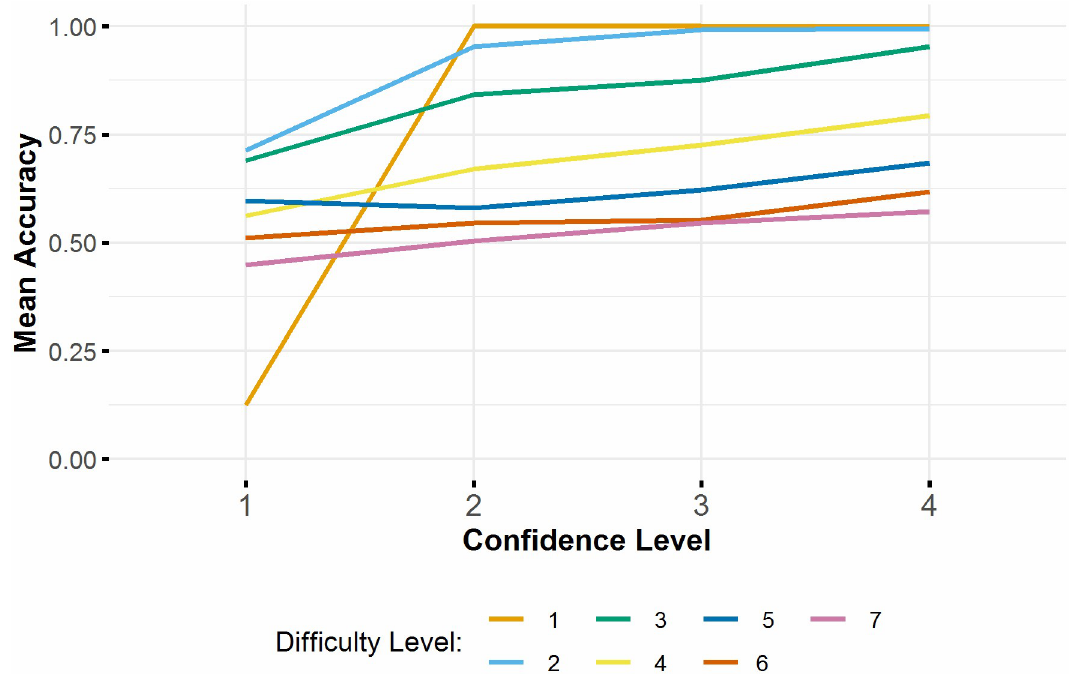
Fig 8. Accuracy in metacognition task at each confidence level, split by trial difficulty. Difficulty Level 1, least difficult; Difficulty Level 7, most difficult.